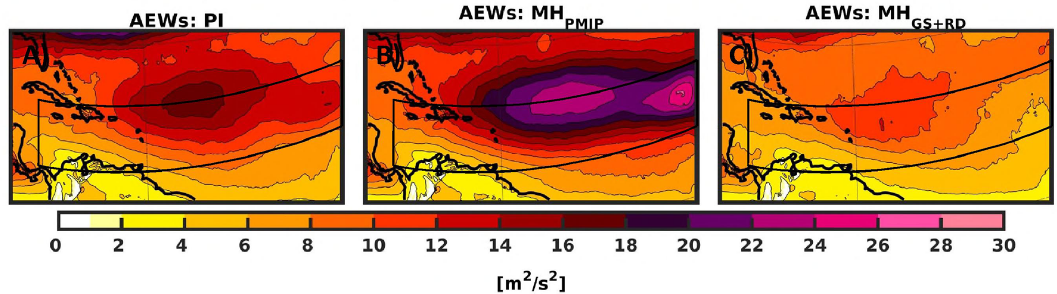
Figure A8. AEWs represented through the variance of the meridional wind at 700hPa, filtered in the 2.5 to 5d band, for the (a) PI, (b) MH PMIP and (c) MH GS + RD experiments. The black box shows the approximate present-day MDR. The contour lines follow the color- bar scale.